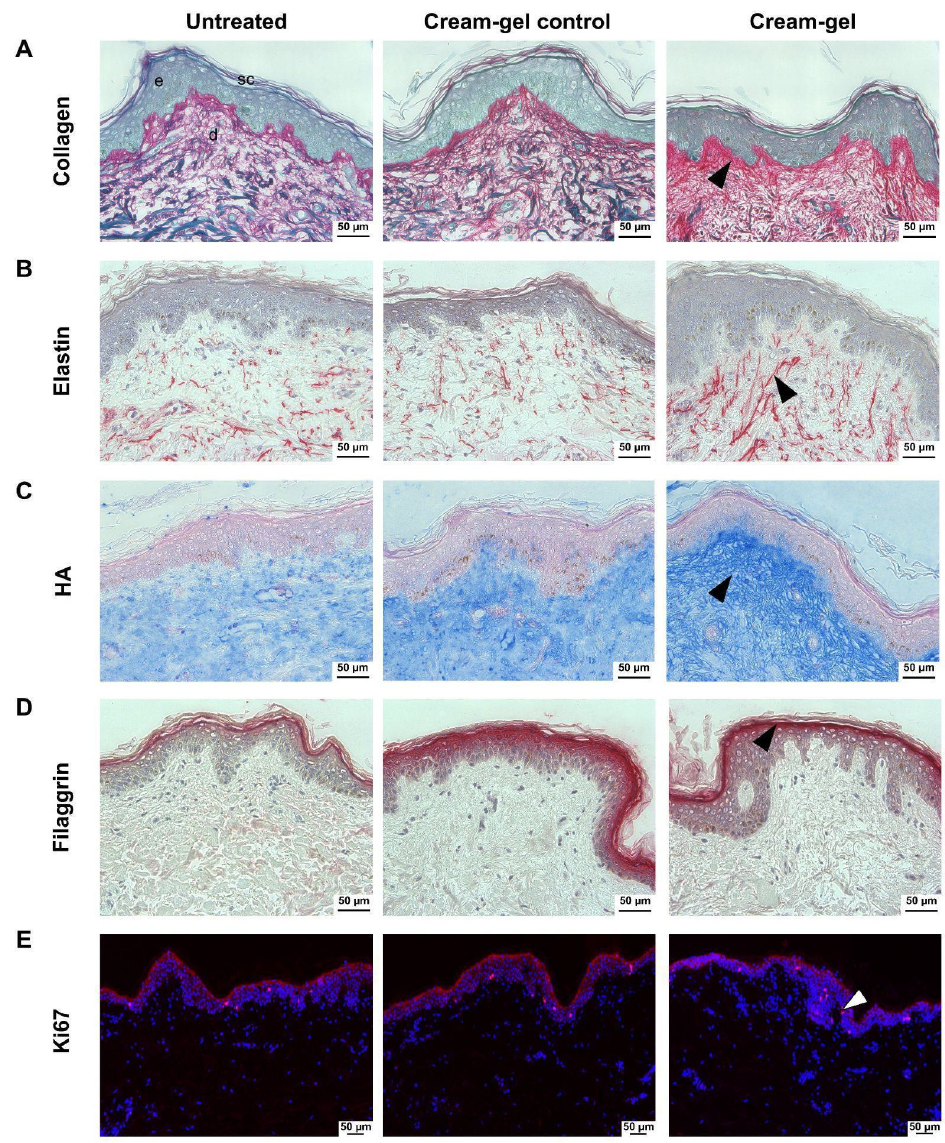
Figure 3. Representative images of the histological changes in the human skin explant model exposed to topical cream-gel or control product. Histological sections of skin biopsies are representative of n = 6 samples in each group (untreated, cream-gel control, cream-gel). Skin is composed of a thin stratum corneum (sc), epidermis (e) and the dermis (d). ( A ) Collagen by picrosirius red staining, ( B ) Elastin, ( C ) HA (Hyaluronic acid) and ( D ) Filaggrin, and ( E ) Ki67 by IHC (ImmunoHistoChemistry). p < 0.05 determined by one-way ANOVA followed by t -test. Arrow indicates papillary dermis, where highest modulation is observed, and quantified to obtain a quantitative score. Scale bar for all images was 50 µ